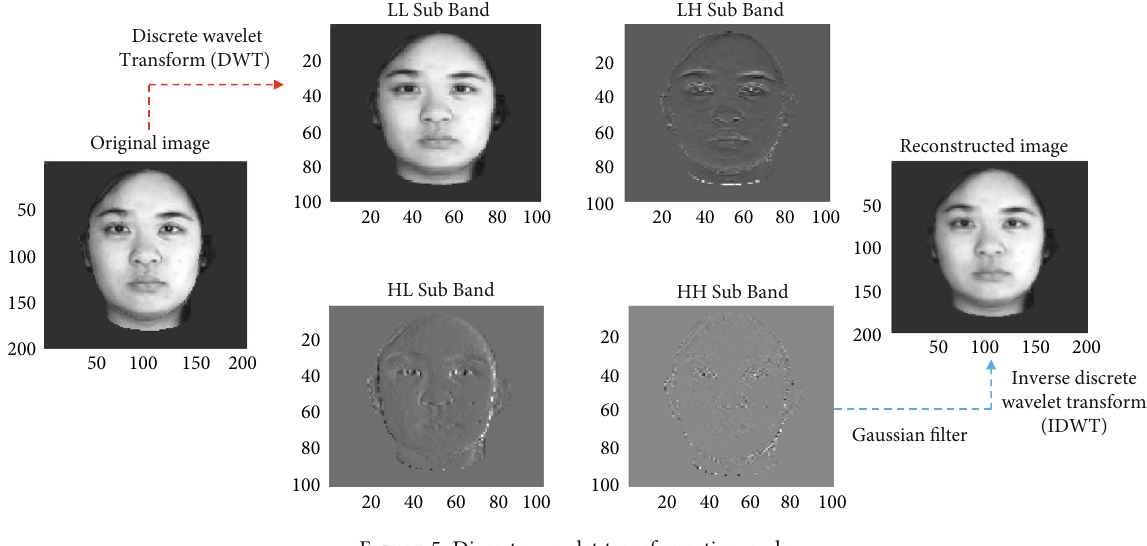
Figure 5: Discrete wavelet transformation